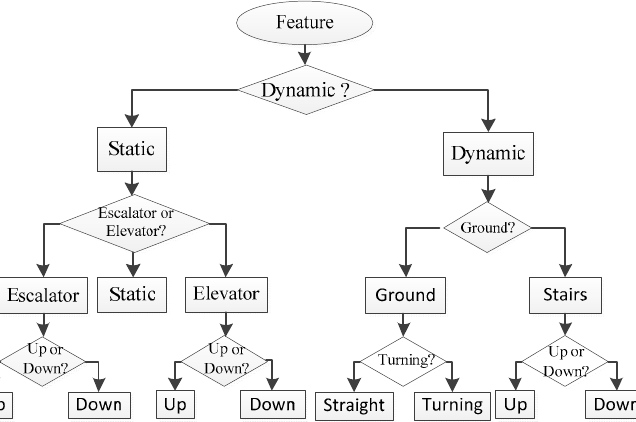
Figure 2. The example of decision tree for motion modes recognition.